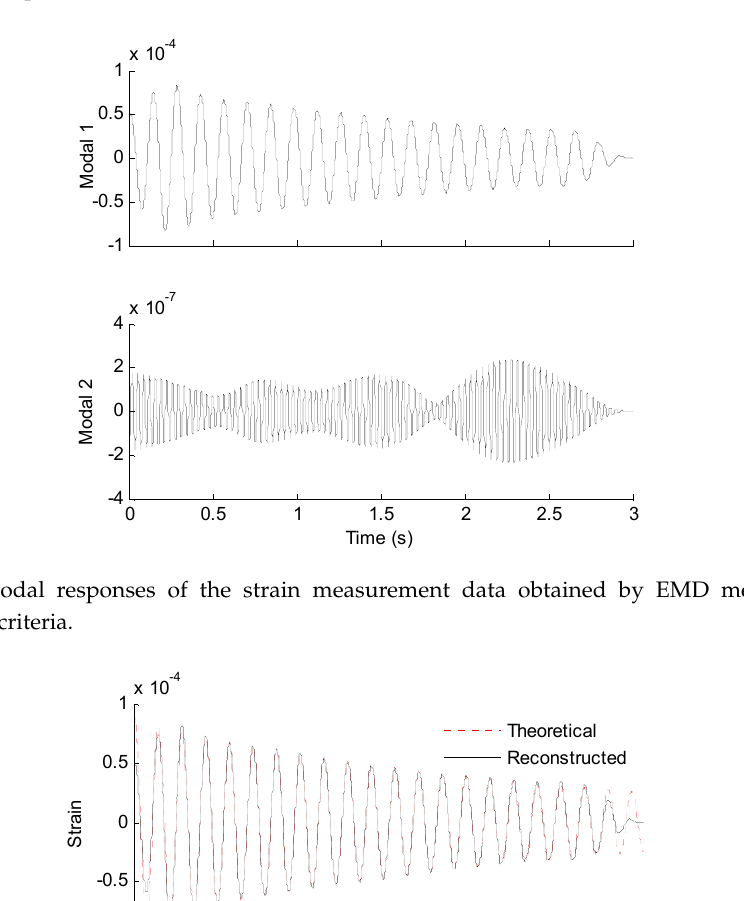
Figure 11. Reconstructed and theoretical bending stress responses for the Loc. I labeled in Figure 7. 3.2.2. Effect of Measurement Noise to Reconstructed Strain and Stress Responses To investigate the effect of measurement noise to the reconstructed strain and stress responses, several numerical cases are studied. To represent realistic situations, the noise signals are Gaussian pulse processes with RMS setting to a percentage of the largest RMS of the calculated strain responses. The percentage value is defined as noise level. For example, a 5% noise level is to generate noise components from Gaussian pulse processes with RMS setting to 5% of the largest RMS of the strain responses. The noise components are added to the strain responses and the results are used as the representative noisy strain measurement data. Correlation coefficient is used as a metric to evaluate the similarity between the theoretical responses and the reconstructed responses for bending